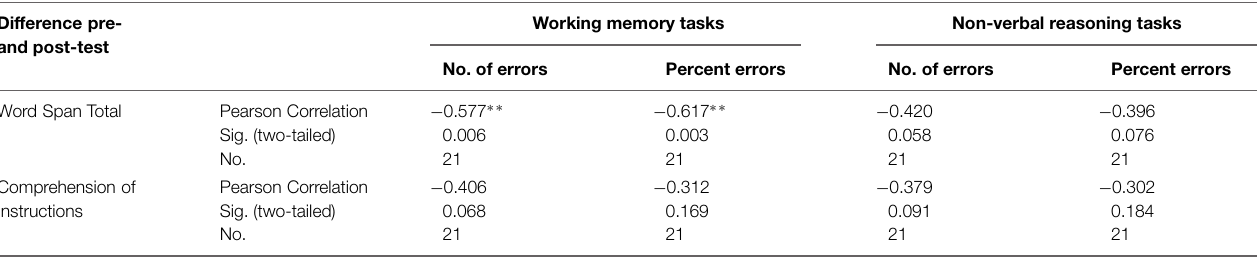
TABLE 4 | Correlation between training failure (number and percentage of errors) and the differences of the T1 and T2 test results (Pearson’s r ). Difference pre- and